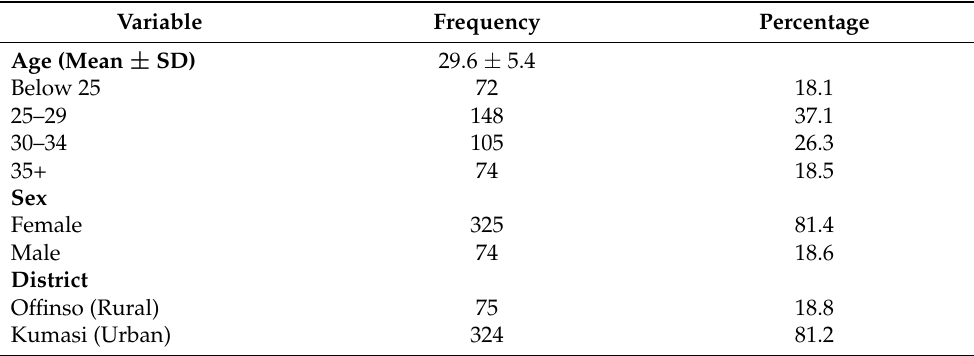
Table 1. Sociodemographic characteristics of